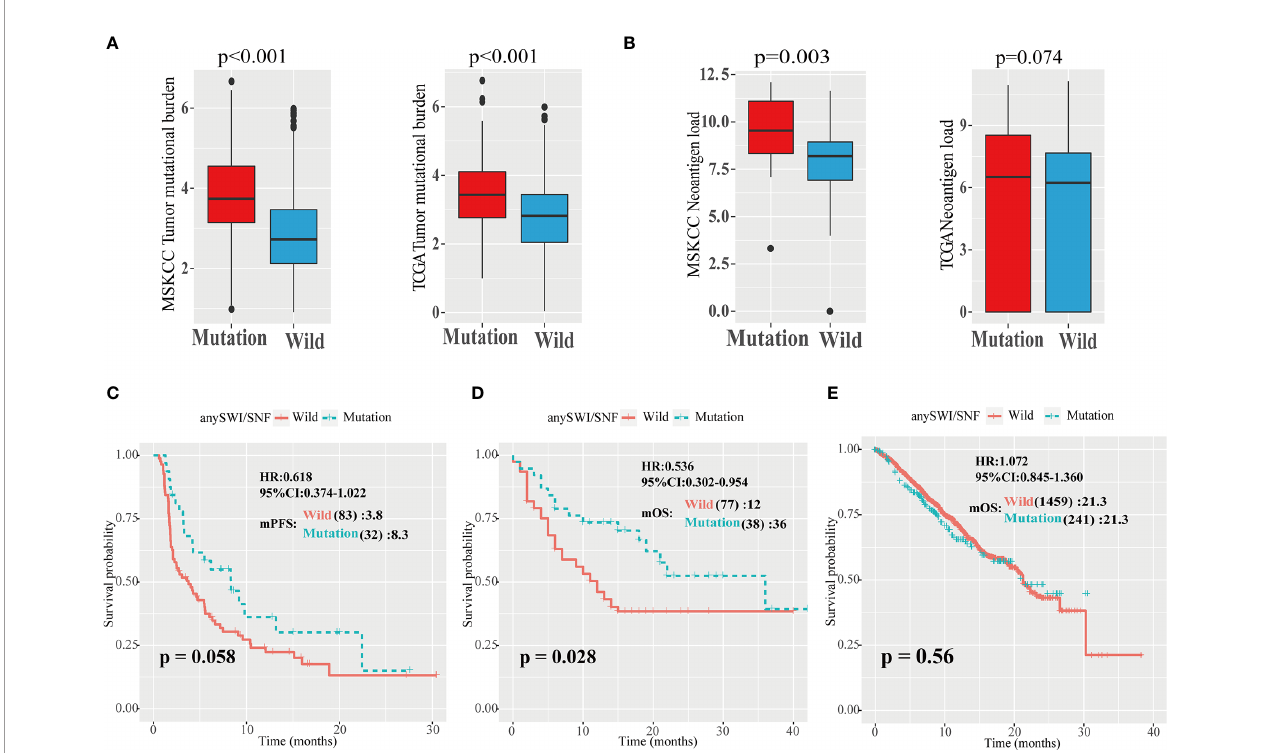
FIGURE 3 | High TMB and neoantigen load of patients with SWI/SNF mutations. (A) Analysis of tumor mutation burden (TMB) values in fi ve independent Memorial Sloan Kettering Cancer Center (MSKCC) cohorts, including the Zehir, Samstein, Rizvi, Naiyer, and Hellmann cohorts (left), and The Cancer Genome Atlas (TCGA) cohort (right). (B) Analysis of neoantigen load in Hellmann (left) and TCGA (right) cohorts. (C, D) Progression-free survival (PFS) curves of patients with non-small cell lung cancer (NSCLC) in the TMB-high group of the Hellmann, Rizvi, and Naiyer (HRN) (C) and Samstein (D) cohorts based on ARID1A , ARID1B , and ARID2 mutations. SWI/SNF, human switch/sucrose nonfermentable. (E) Overall survival (OS) curves of patients with non-small cell lung cancer (NSCLC) in the Zehir cohort based on the human switch/sucrose nonfermentable (SWI/SNF) mutation